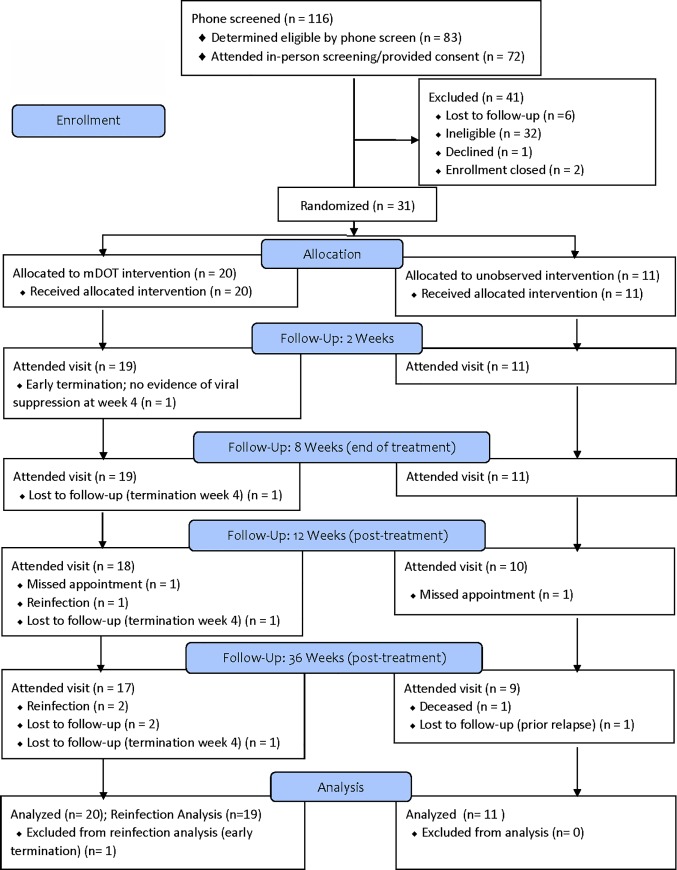
BYE-C consort diagram.